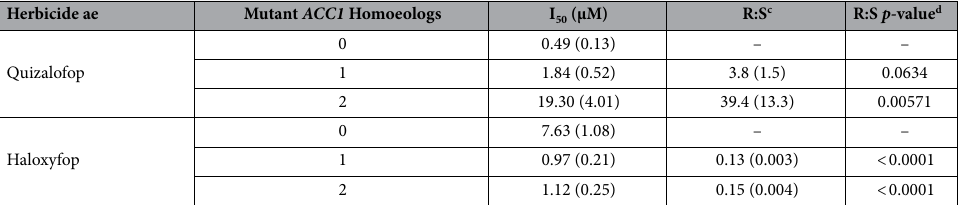
Herbicide ae Mutant ACC1